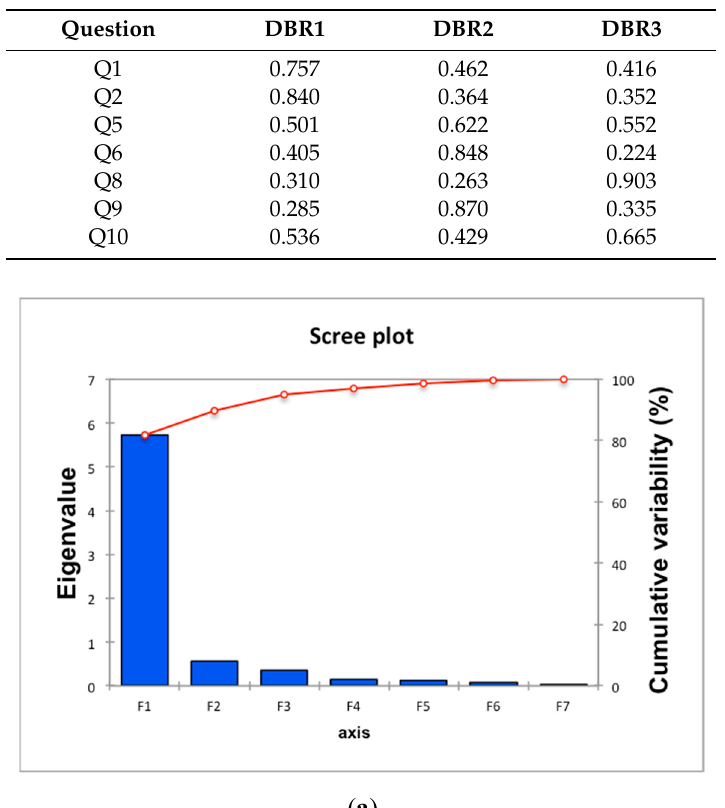
Table 3. Factor analysis questions about BIM: Factor pattern after varimax rotation.